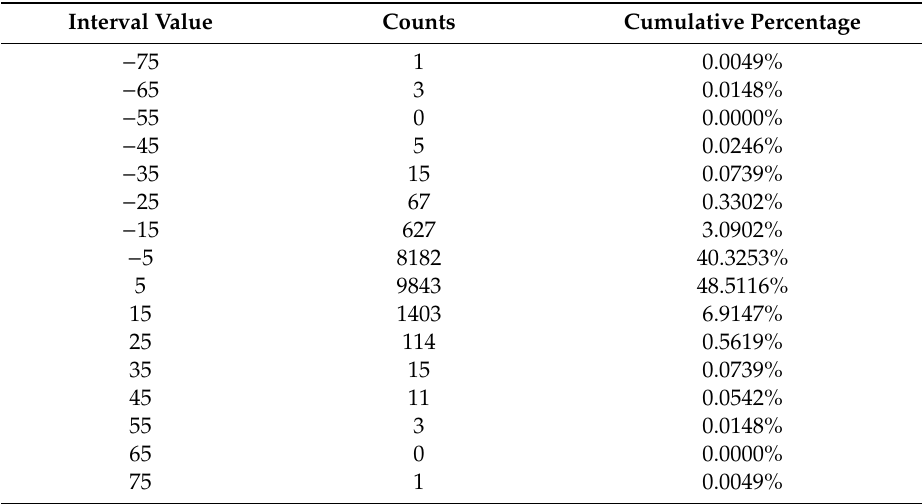
Table 2. Statistical analysis